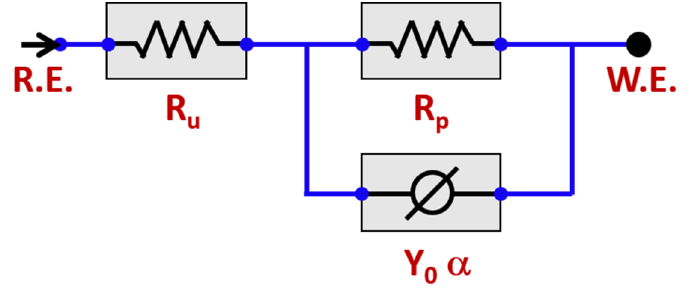
Figure 6. Equivalent circuit model (ECM) employed to fit the impedance data.